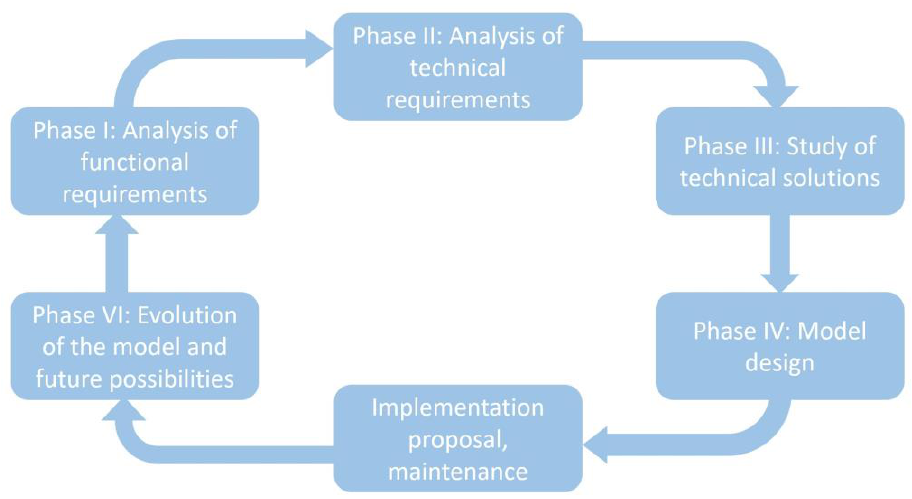
Figure 1. Workflow of the stages of the process proposed in the integration model.